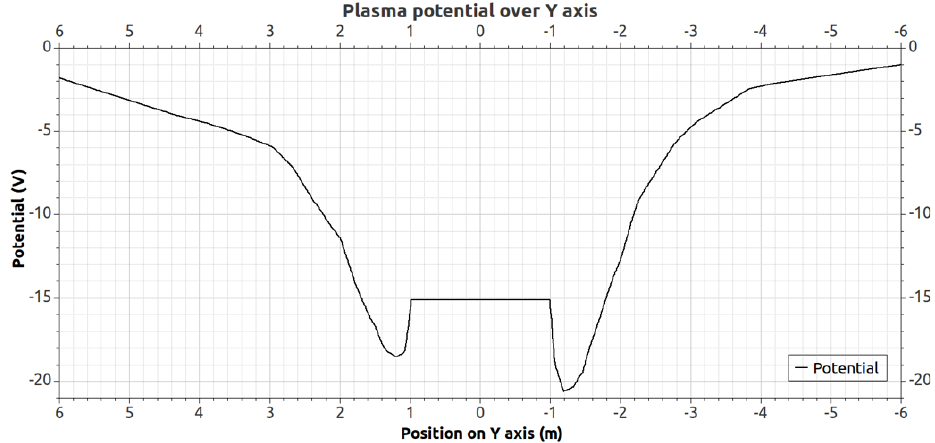
Fig. 17. Simulation S5: plot along the y-axis of the plasma potential. From +6 to − 6m with respect to the potential map Fig. 16: the ions have a Y velocity component from the left side of the plot to the right. Table 5. Final currents and potentials for all S cases. Potential barriers are calculated for secondary particles emitted from the spacecraft (photoelectrons and secondary